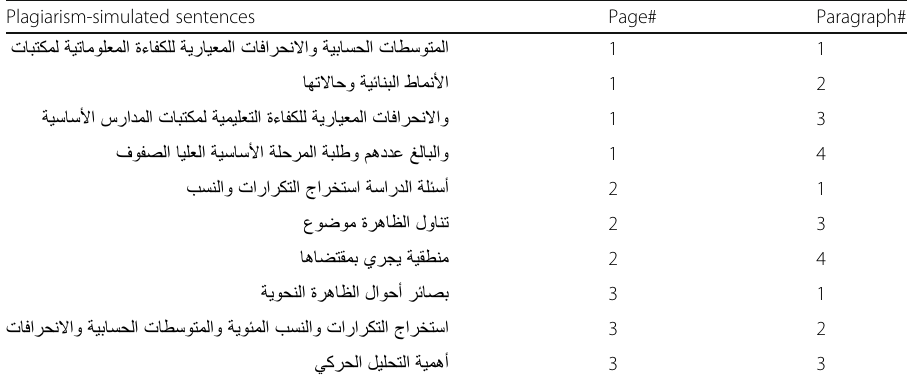
Table 16 Plagiarism-simulated sentences as injected in the original test dataset Plagiarism-simulated sentences Page# Paragraph#